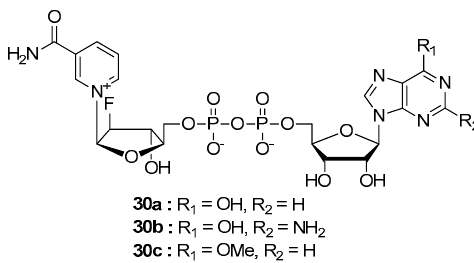
Figure 8. Best potent inhibitors of NADase activity of CD38 described by Wang et al. [58].